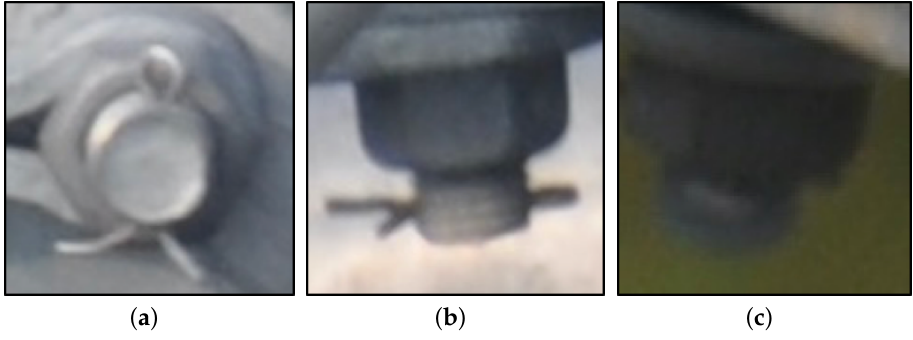
Figure 6. Multiangle image of complete bolt structure. ( a ) Bottle view. ( b ) Front view of visible pin. ( c ) Front view of invisible